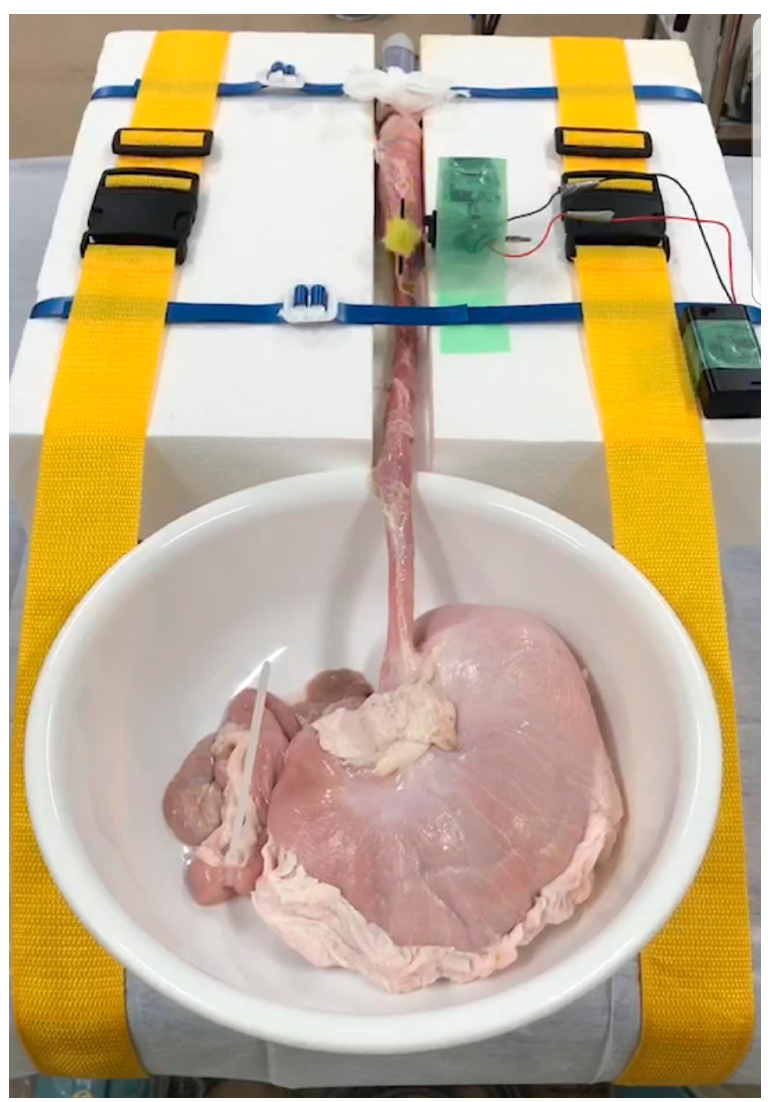
Figure 4. An animal model reproducing pulsations for training in esophageal endoscopic submucosal dissection.